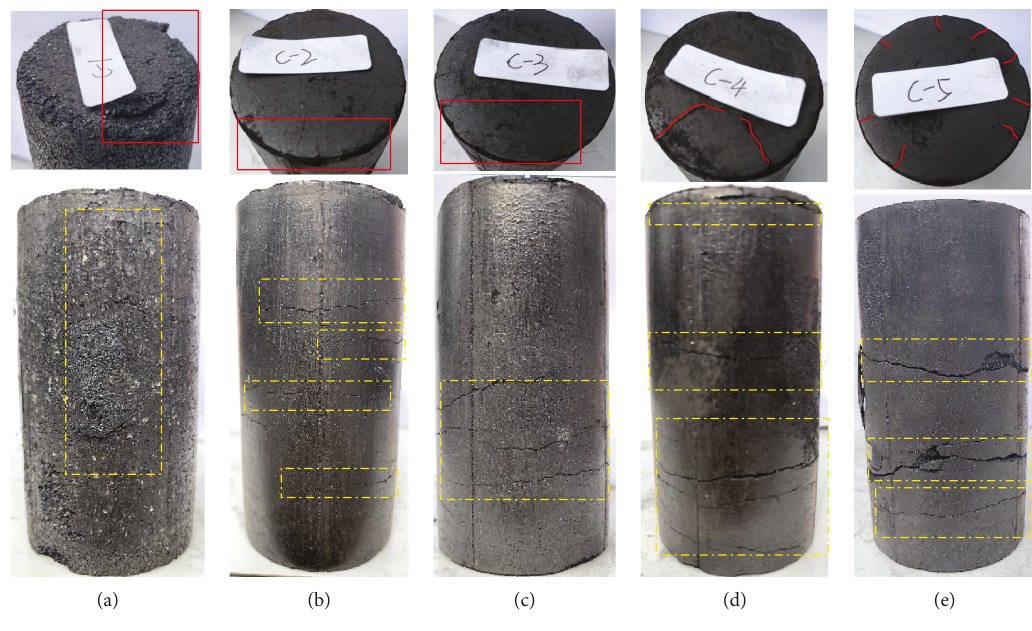
Figure 9: Failure characteristics of coal